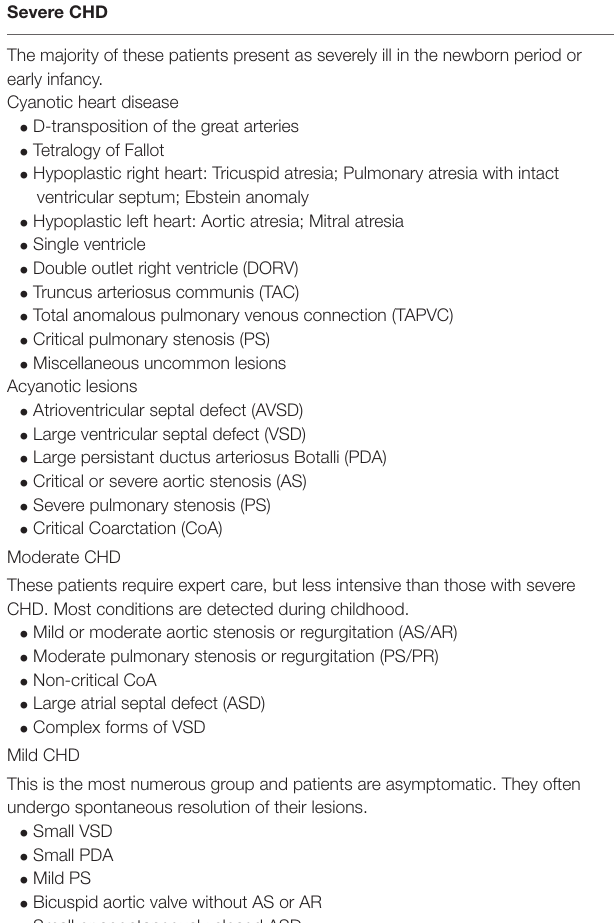
TABLE 1 | Severity grading of congenital heart disease (CHD) [modified after Hoffman et al. (5)]. Severe CHD The majority of these patients present as severely ill in the newborn period or early